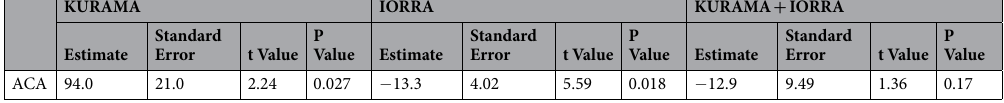
Table 6. An association study between TSS and ACA. KURAMA, Kyoto University Rheumatoid Arthritis Management Alliance; IORRA, Institute of Rheumatology, Rheumatoid arthritis; ACA, anti-centromere antibody; RA, rheumatoid arthritis; TSS, total sharp